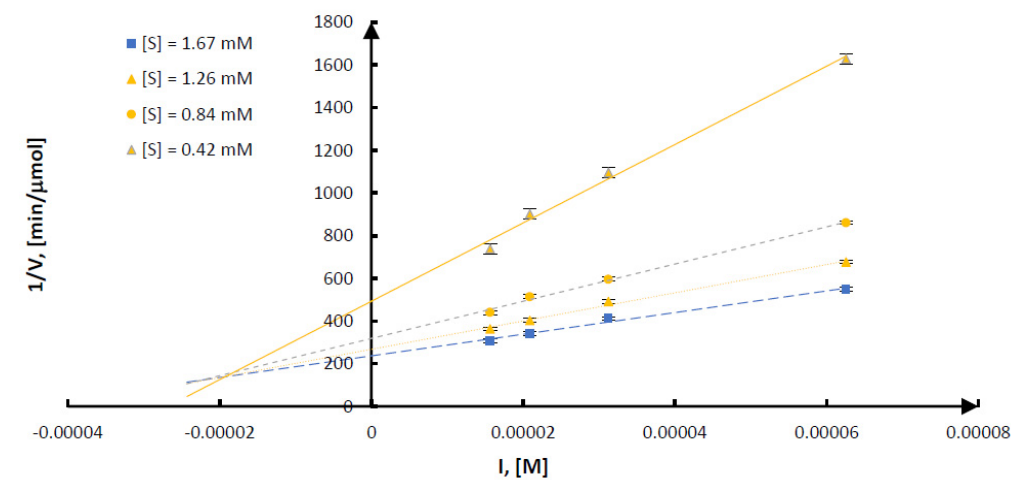
Figure 3. The designation of type inhibition and the inhibition constant K I by Dixon method for compound 3 in the presence of SsLAP.